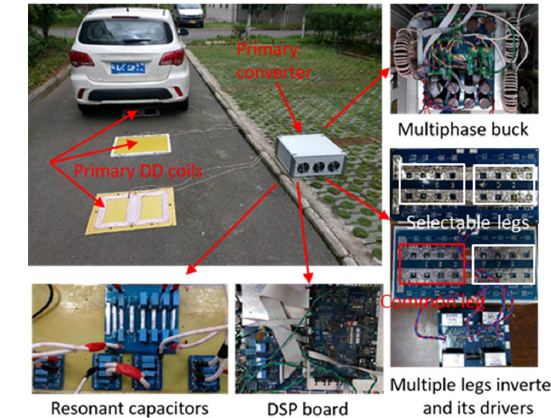
Figure 12. Double LCC resonant network structure.